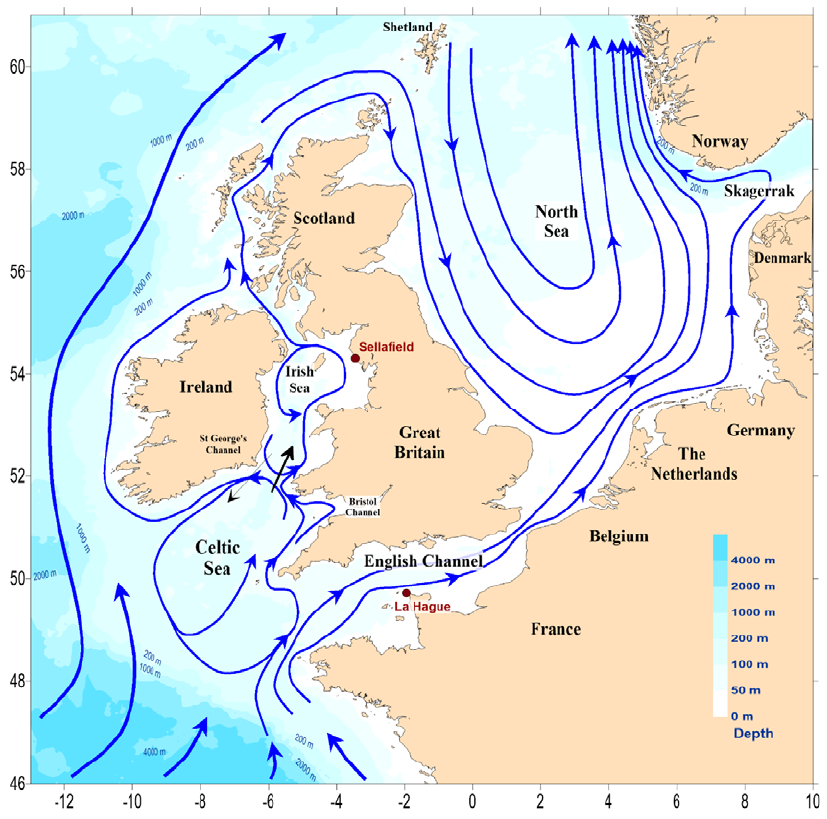
Figure 1. General circulation of water masses in the north ‐ west of Europe, adapted from [11].